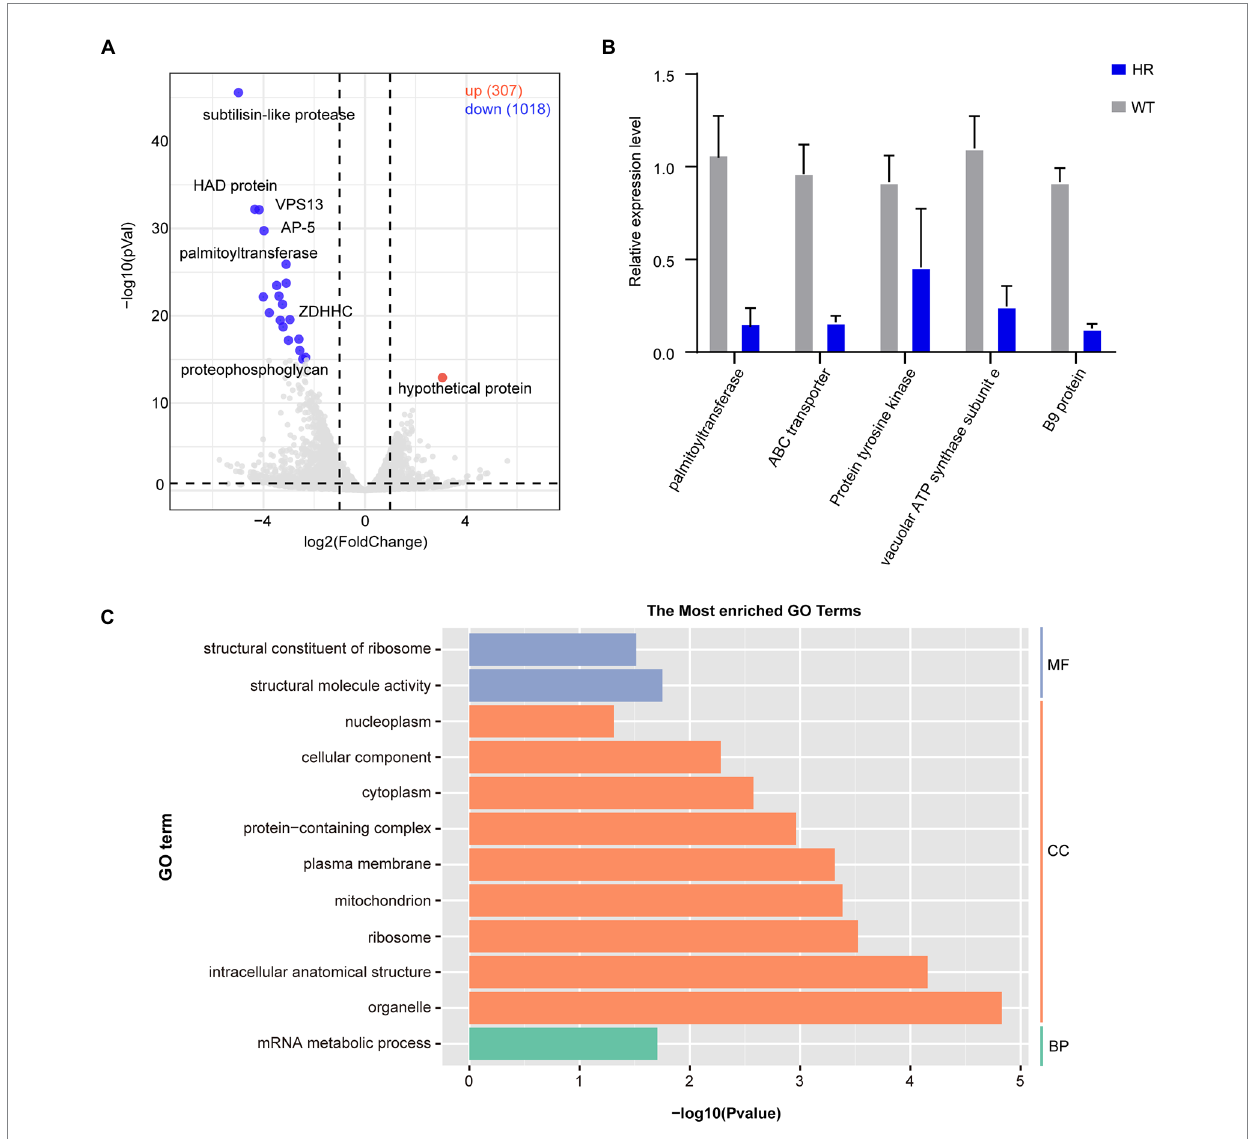
FIGURE 5 Differential gene expression after halofuginone induction. (A) Volcano plot showing the proportion of DEGs between the sensitive group and resistant group. The red dots represented up-regulated genes, the blue dots represented down-regulated genes, and the gray dots showed no significance. (B) Verification of gene expression by real-time quantitative PCR. The black bars with standard errors indicate fold changes based on the relative expression level determined by qPCR using the 2 −ΔΔ CT method for three biological replicates. (C) Functional enrichment of DEGs between halofuginone-sensitive and -resistant strains. The 12 most extensive GO terms of the three GO categories “molecular function” (blue), “cellular component” (orange), and “biological process” (green) are